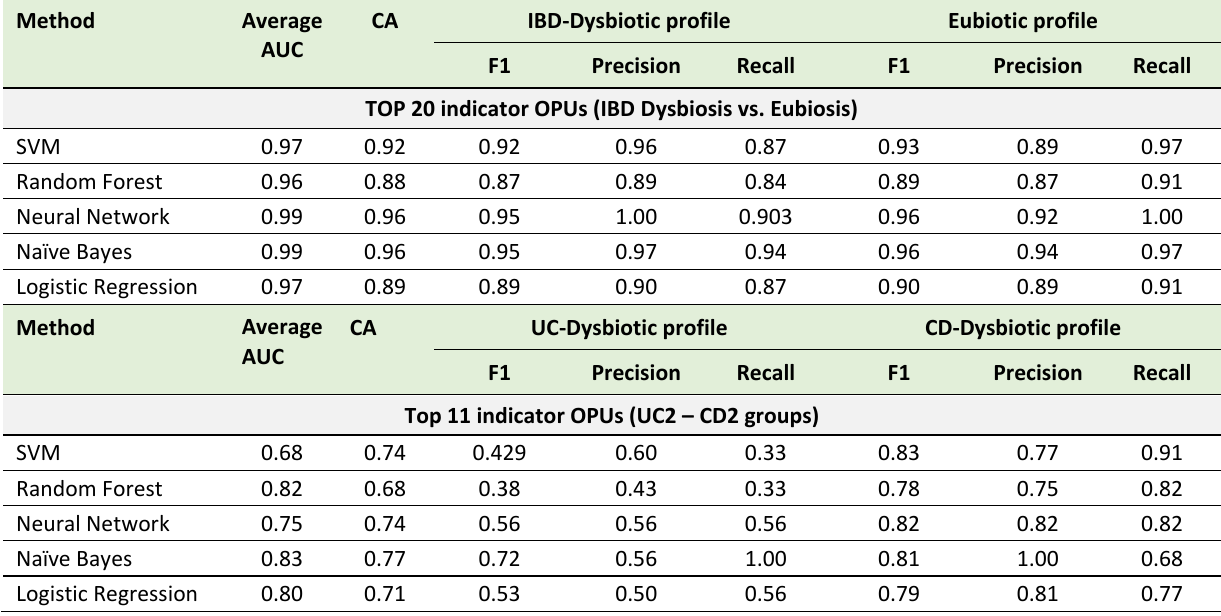
TABLE 1. Cross-validation of bacterial biomarkers and machine learning methods for diagnostic aids in IBD.